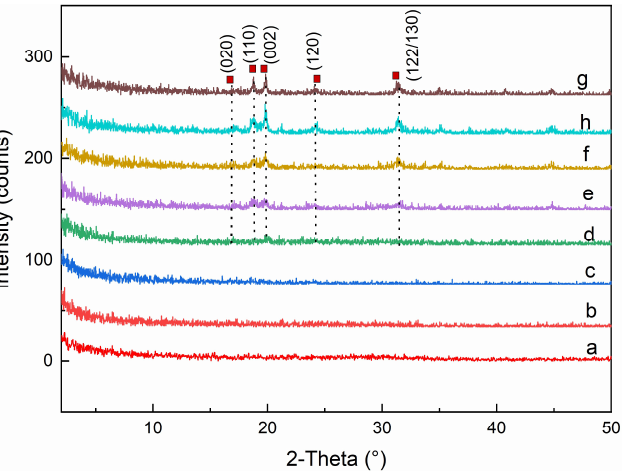
Figure 3. The Powder X-ray diffraction pattern of samples taken at 0 min (a), 180 min (b), 205 min (c), 225 min (d); 235 min (e), 245 min (f); 255 min (h), 450 min (g), respectively.